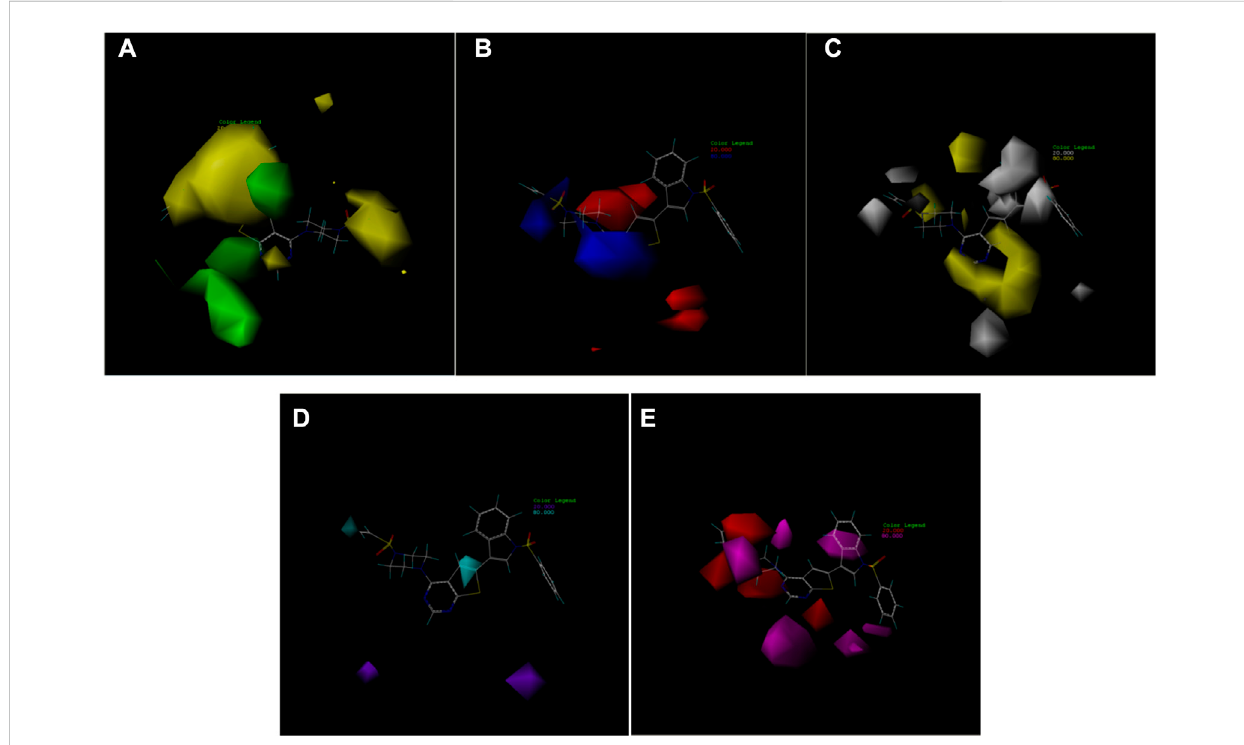
FIGURE 7 Contour map of optimal compound 14. (A) In the steric fi eld, green represents favorable and yellow represents unfavorable. (B) In the electrostatic fi eld, blue represents positive electric fi eld and red represents negative electric fi eld. (C) In the hydrophobic fi eld, yellow represents favorable and white represents unfavorable. (D) Favorable (cyan)and unfavorable(purple)hydrogenbond donor fi elds. (E) Favorable(magenta)andunfavorable (red) hydrogen bond acceptor fi elds.